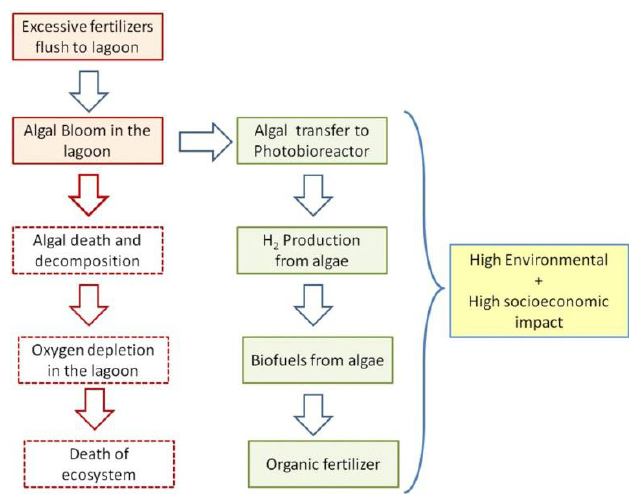
Figure 7. Simplified model based on the separation of eutrophication into two distinct steps (before and after the algal sedimentation), and transferring the second step process to a bioreactor, we can protect the water quality and biodiversity of the lagoons and keep the socioeconomic impact on fish production and community positive. In addition, the environmental impacts will find a sustainable solution through a “smart” biotechnological application that leads to high yield production of hydrogen and biofuels.